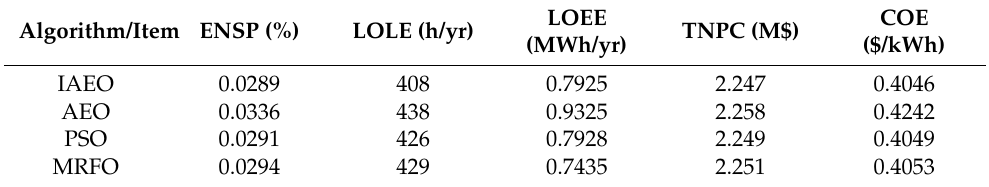
Table 6. Statistical analysis for different algorithms in the sizing of the HPV/FC energy system considering ENSP max = 5%. Table 7. Reliability and cost results of the HPV/FC energy system considering ENSP max =